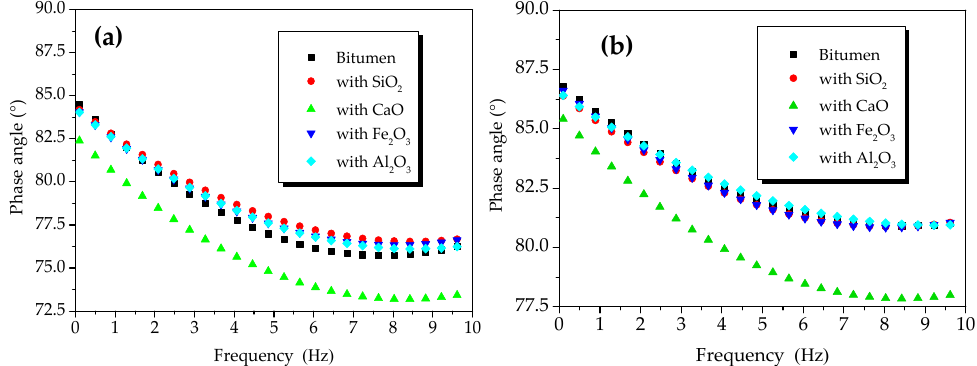
Figure 3. Phase angles of oxide component-modified bitumen mixtures at different temperatures: Phase angle at ( a ) 45 °C and ( b ) 55 °C.